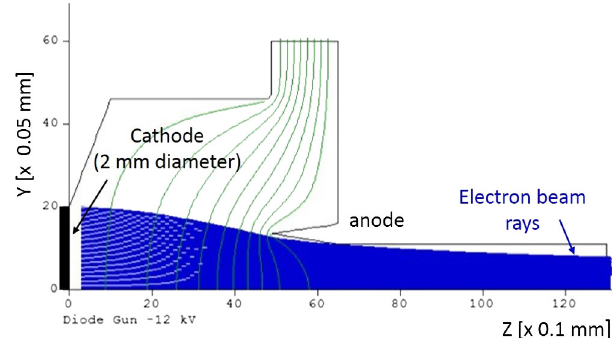
FIG. 1. 2D model of the electron gun. The equipotential lines from the simulations are given in green and the continuous flow of the electron beam is in blue. All units are in 0.1 mm scale.